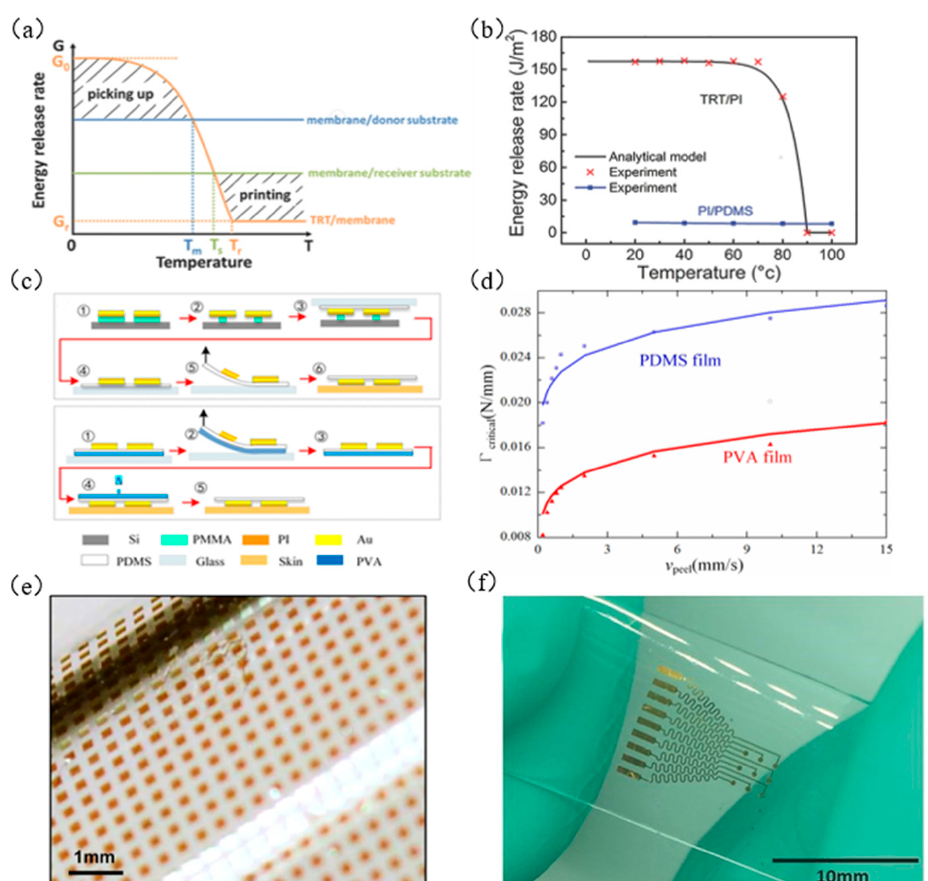
Figure 14. Principles and examples of tape-assisted transfer printing technology. ( a ) Graph of the relationship between temperature and interface energy release rate (reproduced from [76]), ( b ) graph of the relationship between the critical energy release rate and temperature at the interface of TPT/PI and PI/PDMS (reproduced from [76]), ( c ) diagram of adding PVA and adding PVA tape transfer printing (reproduced from [77]), ( d ) graph of the relationship between critical fracture energy and peeling speed (reproduced from [77]), ( e ) array of silicon particles transferred on the surface of a cylindrical tube (reproduced from [75]), and ( f ) nerve electrode array transferred to PDMS (reproduced from [76]).